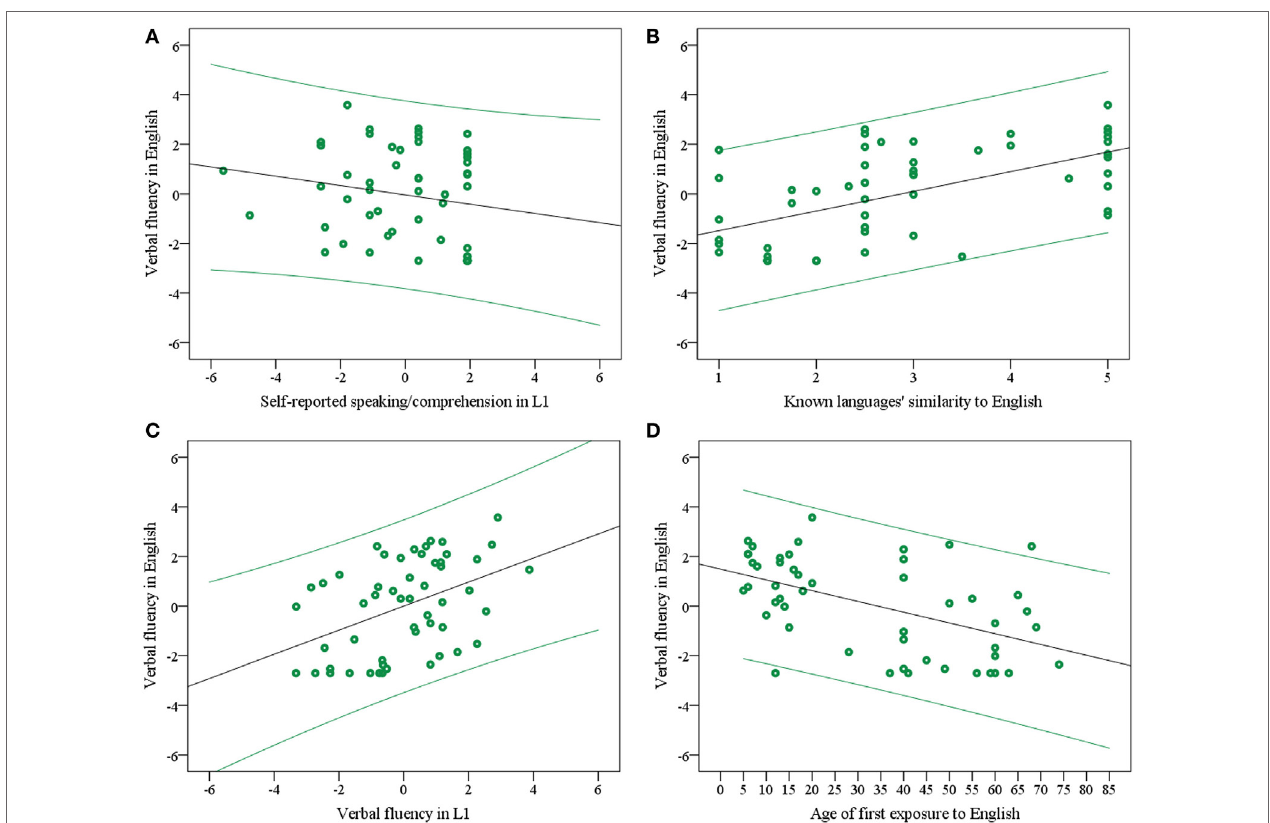
FigUre 4 | Self-reported speaking/comprehension in L1 (a) , similarity to English of the languages known by participants (b) , verbal fluency in L1 (c) , and age of first exposure to English (D) as unique linguistic predictors of English verbal fluency. Pairwise correlations are plotted with error lines representing 95% confidence